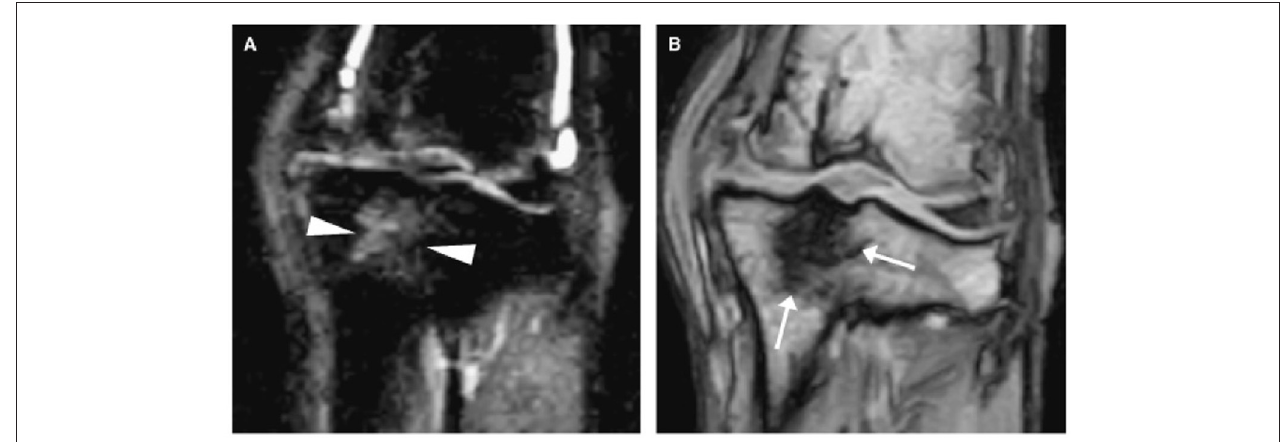
FIGURE 8 | Two dorsal stifle MRI images of a dog 13 months after a CCL transection showing a bone marrow lesion (BML) within the dorsal tibia. (A) is a short tau inversion recovery sequence (STIR) which shows the BML as a heterogeneous hyperintensity in the dorsal tibia (arrow heads), while (B) is a T1-weighted sequence where the BML appears as a hypointense lesion (arrows). MRI – Magnetic resonance imaging; CCL – cranial cruciate ligament. Martig S et al. MRI characteristics and histology of bone marrow lesions in dogs with experimentally induced osteoarthritis. Vet Radiol Ultrasound. 2007; 48(2):105–12. Reprinted with